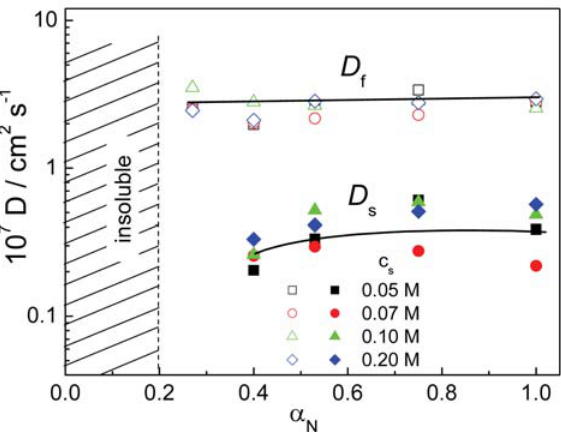
Figure 6. Dependence of the fast, D cient, D , on degree of neutralization, α s tions with c = 2 g/L and at various CsCl concentrations, c p 0.05–0.20 M). The shaded area designates the α iPMA is insoluble in